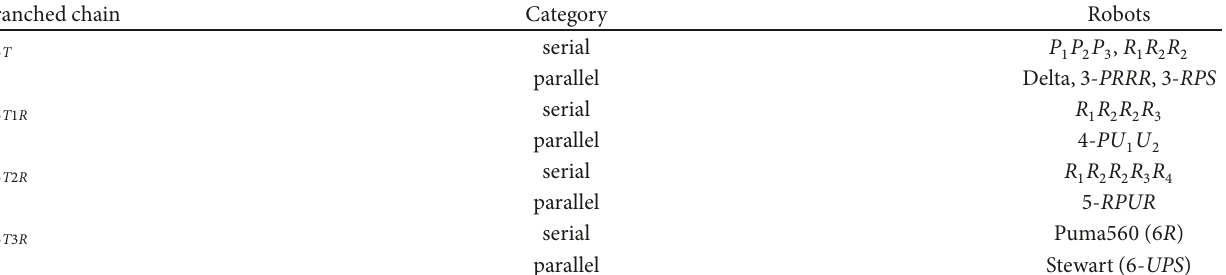
Table 3: Common robots with 3 to 6